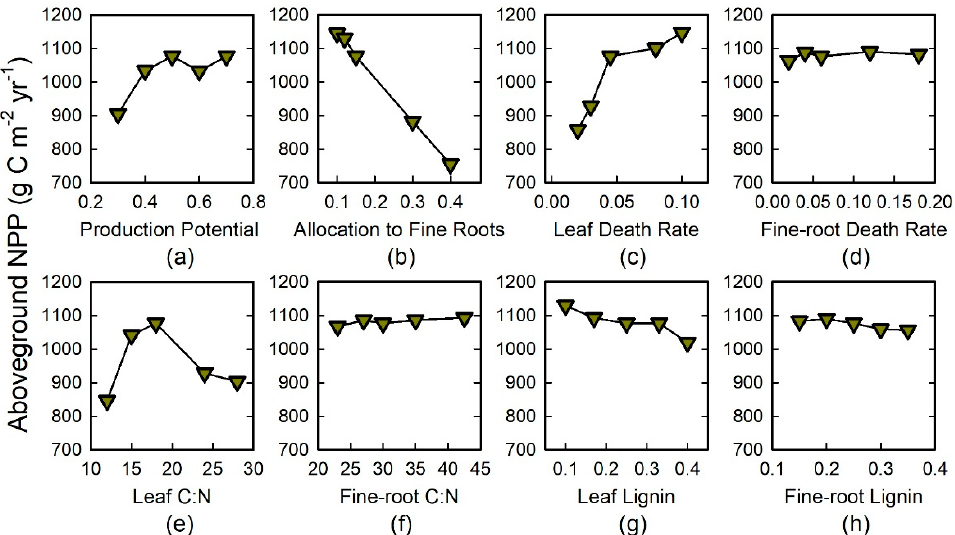
Figure 5. Sensitivity analyses to evaluate effects of traits of tree species on aboveground NPP. Plant traits included: ( a ) production potential; ( b ) allocation to fine roots; ( c , d ) leaf and fine-root death rate; ( e , f ) leaf and fine-root C:N; and ( g , h ) lignin content. The middle value corresponds to input data for ‘LSM’, La Selva mature forest.